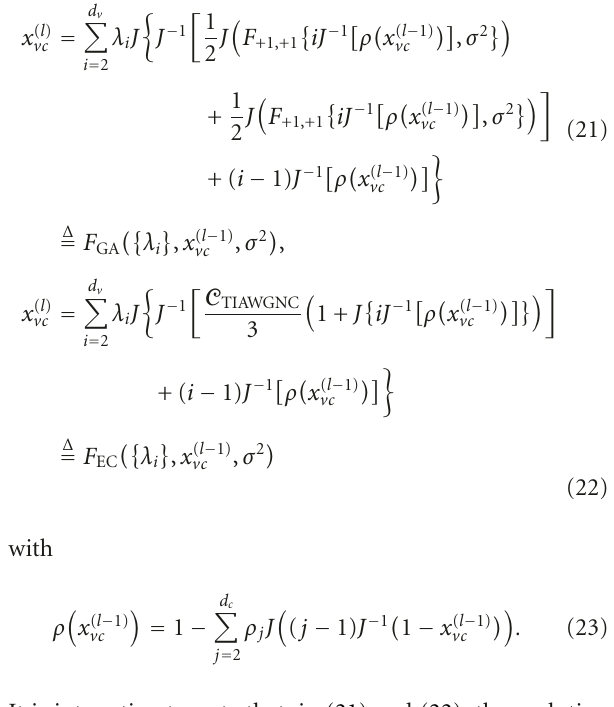
Figure 2: Mutual information evolution at the state-check node. Comparison of the approximation methods with the exact mutual information at the state-check node. The solid lines represent the GA approximation, the broken lines the EC approximation, and plus signs show Monte Carlo